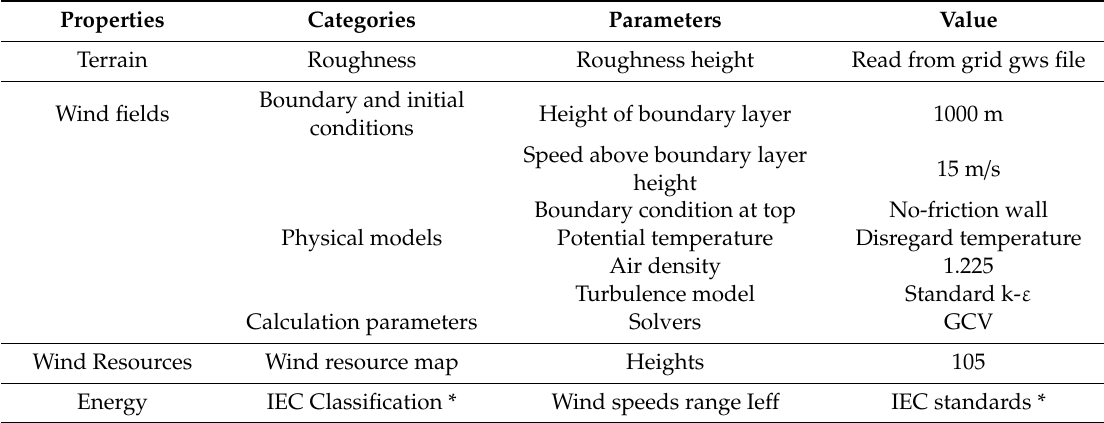
Table 4. Parameters adopted to build a wind resource model in this